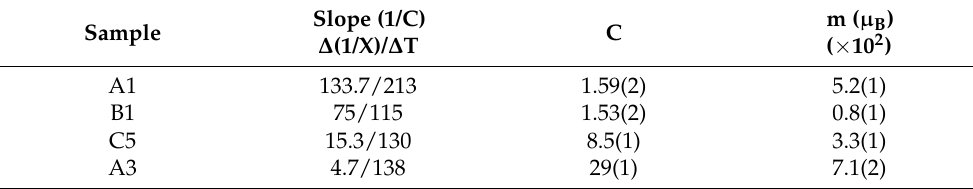
Table 3. Experimental calculation result of m by means slope of 1/X by T a .